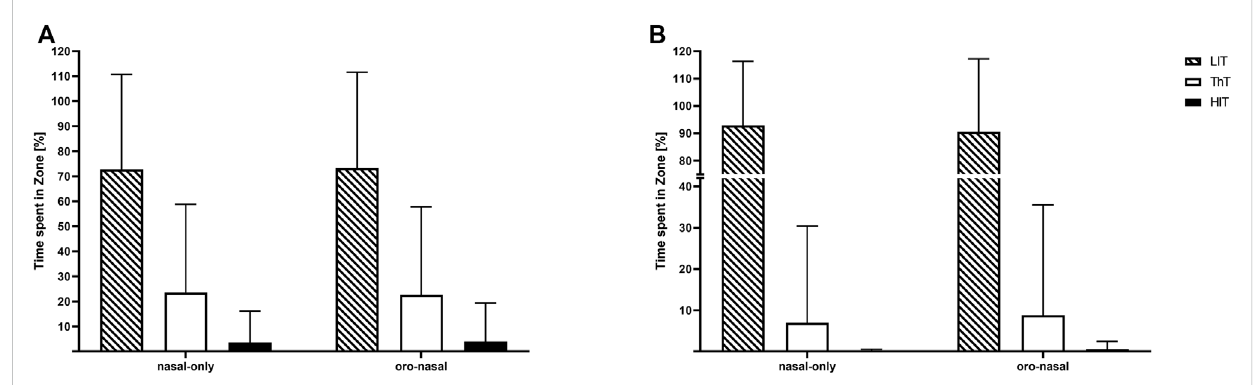
FIGURE 2 Meanvalues andstandarddeviationsfor therelativetimespent intraining zones[LiT:low-intensity training(dashed);ThT:thresholdtraining (white); HIT: high-intensity training (black)]. Calculated based on power (A) and heart rate (B) for the nasal-only and oro-nasal training